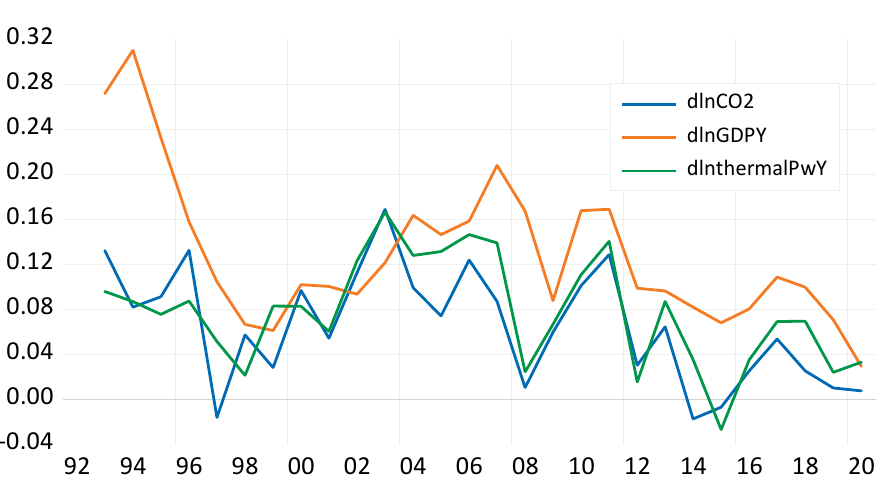
Figure 3. The trend of the three variables.